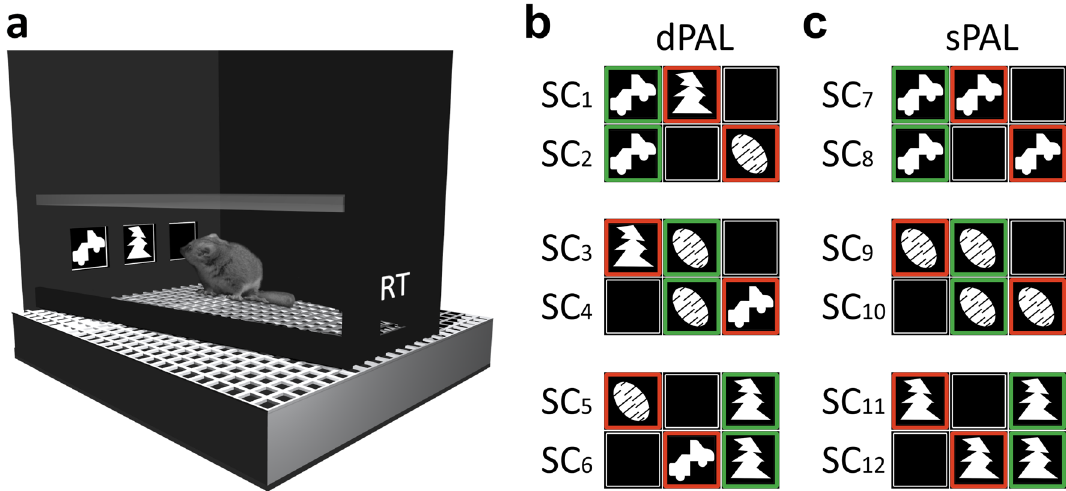
Figure 1. Schematic representations of the setup and the stimulus combination used for cognitive testing. ( a ) Drawing of the trapezoidal (width: front = 245 mm; back = 130 mm; length = 330 mm) testing chamber (left side wall and liquid reward dispenser removed). The touchscreen at the front end was covered by a black Perspex mask with three square (width: 45 mm; height: 45 mm) response windows (left, centre, right). The reward tray (RT) was located at the back end of the chamber. The height of the chamber was limited to 100 mm by a translucent lid. ( b ) Stimulus combinations used during dPAL training (SC 1 –SC 6 ). In each of the six possible combinations, one of two different stimuli was presented at its rewarded location. The second, simultaneously presented stimulus was used as a distractor at one of its two unrewarded locations. c Stimulus combinations used during the sPAL challenge (SC 7 –SC 12 ). In each of the six possible combinations, the same stimulus was presented as doublet, at its rewarded location and, as a distractor, at one of its two unrewarded locations. ( b , c ) Green border = S + ; red border = S - . For copyright reasons, the depicted stimuli are those used for the collection of longitudinal data in three individuals. For the first training of all twelve individuals and the subsequent sPAL challenge in seven individuals, the “flower-plane-spider” set of stimuli introduced by Talpos and colleagues 12 was used. In this original set, the flower was rewarded at the left location, the plane was rewarded at the centre location, and the spider was rewarded at the right lemurs is available elsewhere 15,20 . In brief, animals were first trained in a 5-step autoshaping procedure, in which they were conditioned to reliably (more than 80% of the decisions made) interact with random black-and-white stimuli presented behind one out of three possible, pseudo-randomly chosen response windows (RW) on a touchscreen. Afterwards, animals were tested in the CANTAB dPAL protocol (Fig. 1b). During dPAL testing, the animals had to procedurally learn to distinguish three novel pictorial items (a flower, a plane, and a spider) and to associate each of them with a unique, rewarded location (left, centre, right) on the touchscreen. During regular trials, two different of these items (hence the “ d ” in dPAL) were presented simultaneously, one (the S + ) at its rewarded location (flower: left RW; plane: centre RW; spider: right RW), the other one, as a distractor (S - ), at one of its unrewarded locations. Touch interactions with the S + were rewarded with a small amount of apple juice (15 µl), touch interactions with the S - or with the blank screen behind the third, “empty” RW led to trial termi- nation, signalled by a pure tone (2 kHz, 0.5 s) and a time-out of 5 s. Incorrect trials were followed by correction trials, in which the same stimulus combination as in the preceding trial was reused, until the correct response was eventually given. Correct trials, on the other hand, were followed by the next regular trial. Only responses given during regular trials increased the trial count and were used to assess individual PAL performance. Within a given block of regular trials, each of the six possible stimulus combinations (SC 1 -SC 6 ; for examples see Fig. 1b) was presented equally often, using a balanced, pseudo-randomized session design. Animals trained in the session-based protocol (n = 5) were trained in a single session of 36 trials or a maxi- mum duration of 1 h per day. Session-based training was always conducted within the first 2 h of the artificial dark phase, i.e. at the beginning of the animals’ active phase. Training ended as soon as the animals had reached a criterion of at least 80% correct decisions in two consecutive, complete (= 36 completed trials) sessions (72 trials in total; criterion 1 = C 1 ). Animals trained in the home cage-based protocol (n = 7) had almost unlimited access to the testing chamber on working days. Access was denied only for maintenance purposes (e.g. cleaning of the setup, refilling of the reward depot), which took place once per day during the artificial light phase, i.e. during the inactive phase of the nocturnal animals. Animals could enter the testing chamber directly from their home cage via a short tunnel. The general testing procedure was the same as for the animals trained in the session-based procedure. The only difference was that the number of trials an individual could complete per day was only theoretically limited by the size of the reward depot holding 2000 rewards (30 ml). While this limit was never reached, animals trained in the home cage-based protocol usually completed substantially more than 36 trials per day. The average number of trials per day during training to C 1 was 122 and increased with increasing training. To exploit this advantage of the procedure and to allow comparisons of different criteria, individuals were trained to a more conservative